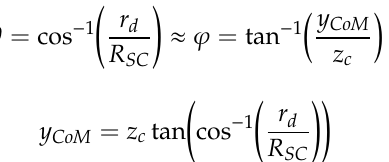
Figure 2. ( a ) Turn radius 𝑟 (cid:3031) ; ( b ) Parameters characterizing of ski geometry; ( c ) Edging angle 𝜃 and penetration depth 𝑒 .